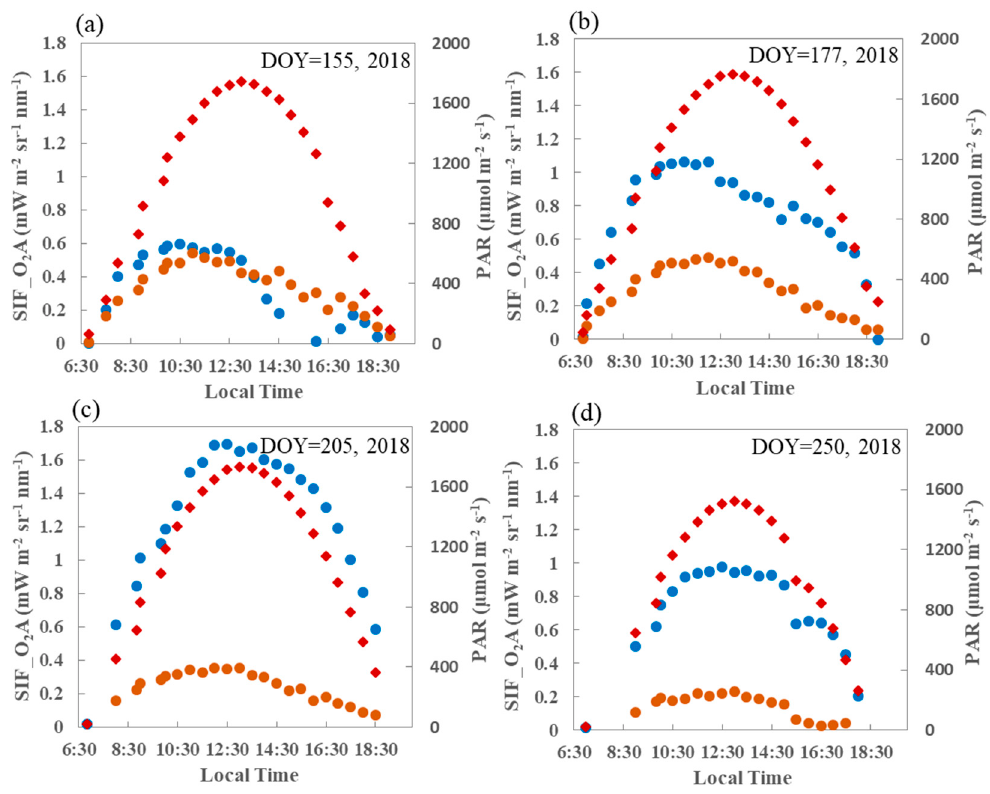
Figure 9. Diurnal variations in SIF at both the O 2 –A (blue) and O 2 –B (orange) bands and in photosynthetically active radiation (PAR) (red) at the DM site on four different days during the 2018 growing season. DOY—day of year.